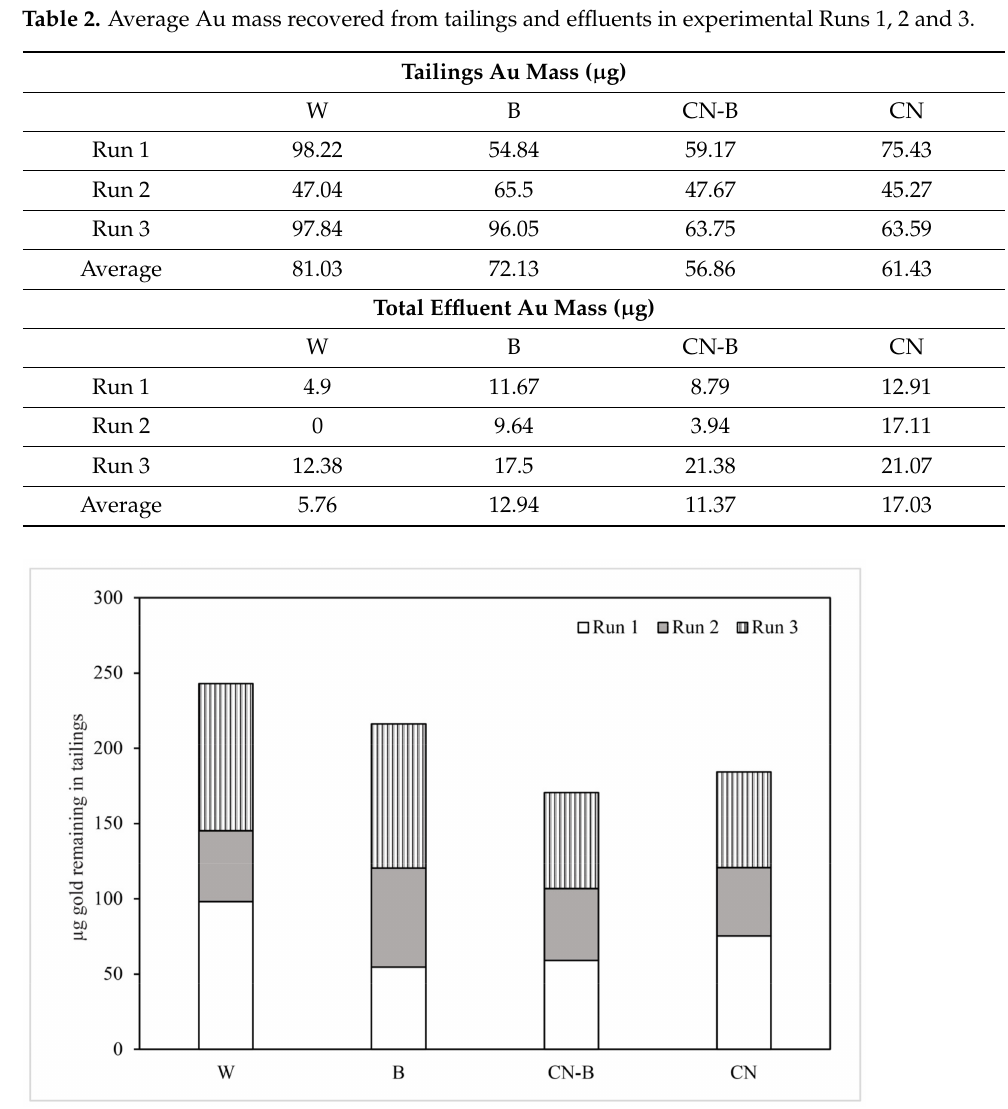
Figure 4. Total Au remaining in column tailings in µ g. Lixiviant treatments are noted as follows: W for deionized water; B for A. faecalis ; CN-B for cyanide-bacteria; and CN for cyanide columns. The Au recoveries from the effluents as a percentage of total gold recovered (post-run tailings + effluent) are shown in Figure 6. Overall, the % recovery from the B column was comparable to the recoveries from the CN-B and CN columns. However, most of the Au was leached in Week 1. In Run 3, the % recovery was higher for all the columns than in the previous runs, possibly due to a higher starting concentration of Au in the Heap 5 subsample. This possibility is reflected in the remaining gold measured in the tailings after treatment with the